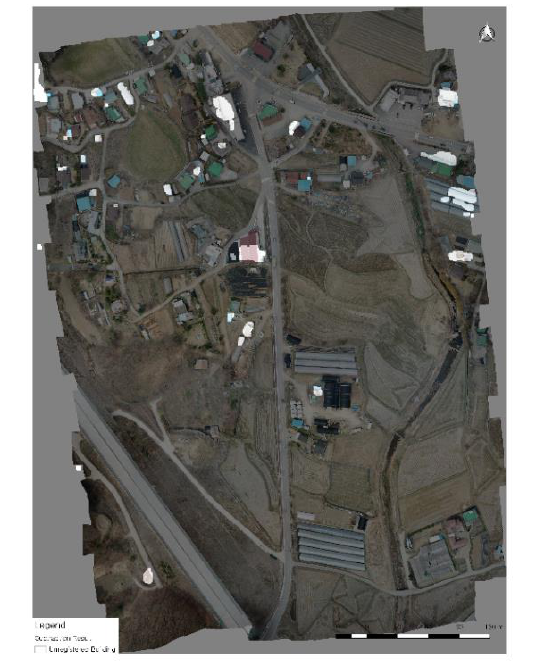
Figure 14. Result of unregistered building detection The system succeeded to detect 85% percent of unregistered buildings which we digitized manually. The system detected not only unregistered buildings but also extended buildings as shown in figure 15.